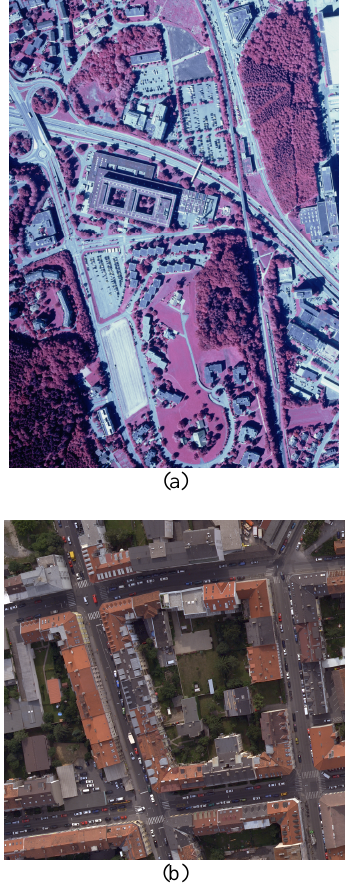
Figure 1. KLOTEN (a) and GRAZ (b)